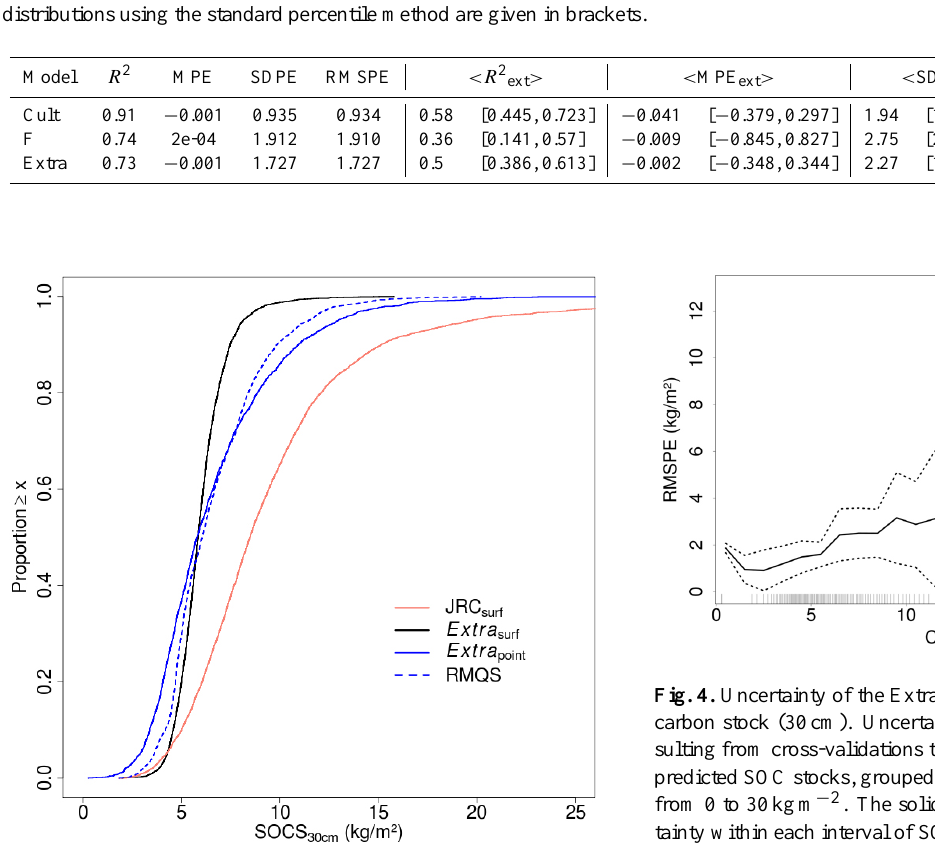
Fig. 3. Empirical cumulative distribution functions (ecdf) for the two spatial estimates presented in this paper (using the Extra model and the JRC estimate) as well as for the observed (curve RMQS) and predicted (curve Extra point ) SOC stocks at RMQS sites. Comput- ing ecdf on spatial estimates is done as follows: first the statistical population is made of each spatial unit where the prediction model has been applied (the Extra model for instance). Second, a weight is computed for each unit as the ratio between its area and the sum of spatial units area (here, the area of France). Third, the ecdf is esti- mated on models predictions within the spatial units (kgm − 2 ) using weights previously calculated. Ecdfs of site observed or predicted values are calculated using equal weights between individuals.